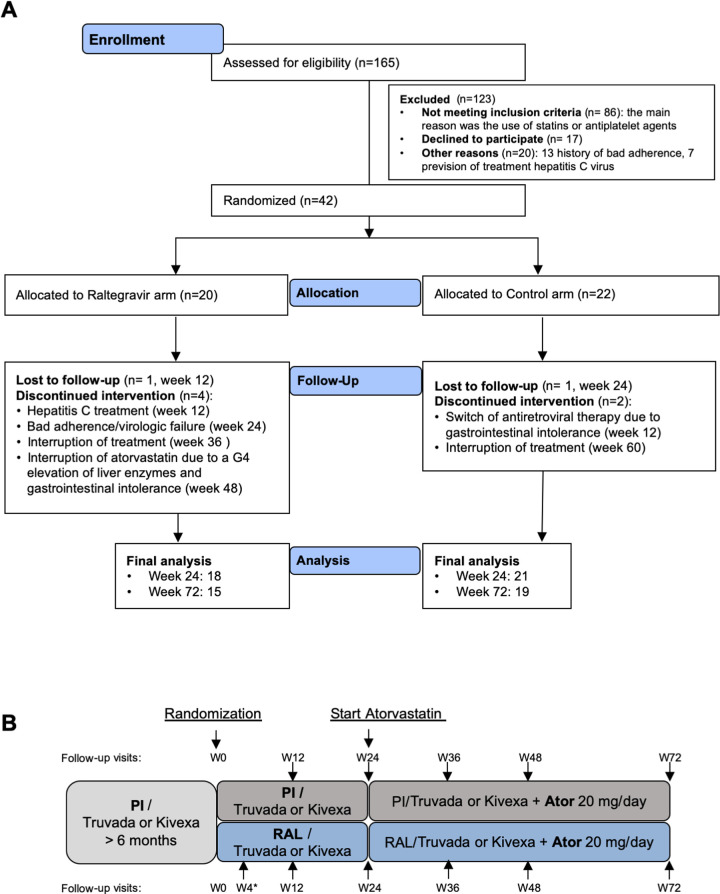
Trial design.A. Consolidated Standards of Reporting Trials (CONSORT) flow diagram for the trial showing Participant flow in Control and Raltegravir groups. B. Schematic representation of intervention, patients were randomized to the Control and Raltegravir groups and, after 24 weeks, atorvastatin was added to all participants. Follow up visits are indicated for each group.